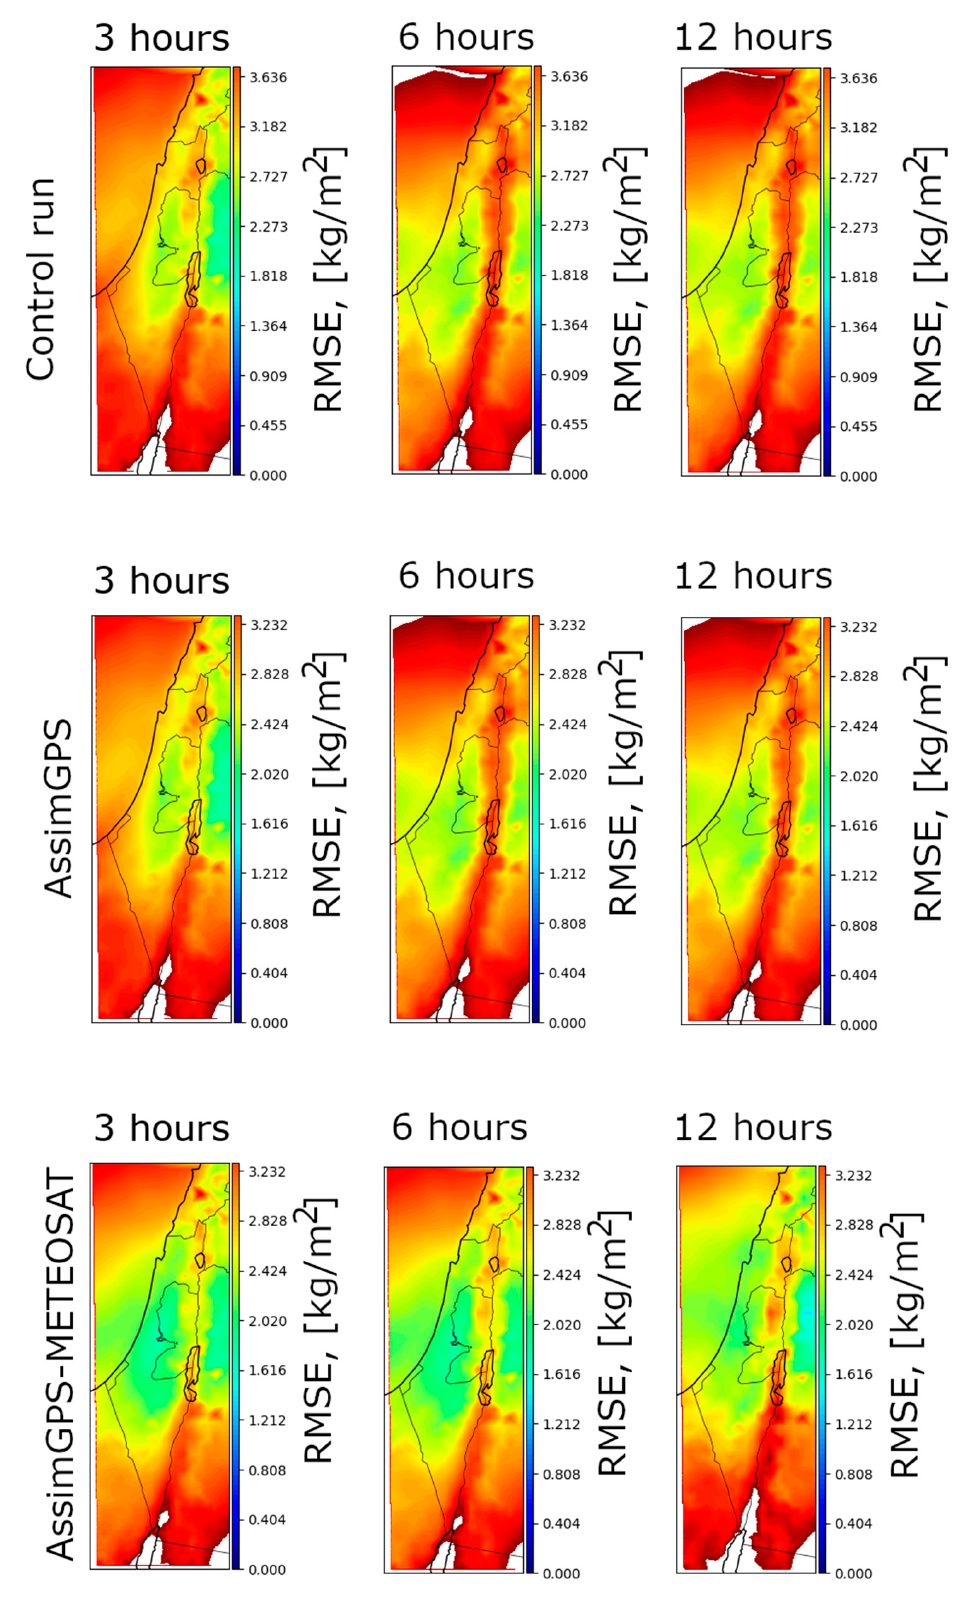
Figure 8. Root mean square error (RMSE) maps between the 2D GPS-IWV-METEOSAT and different types of WRF forecasts.